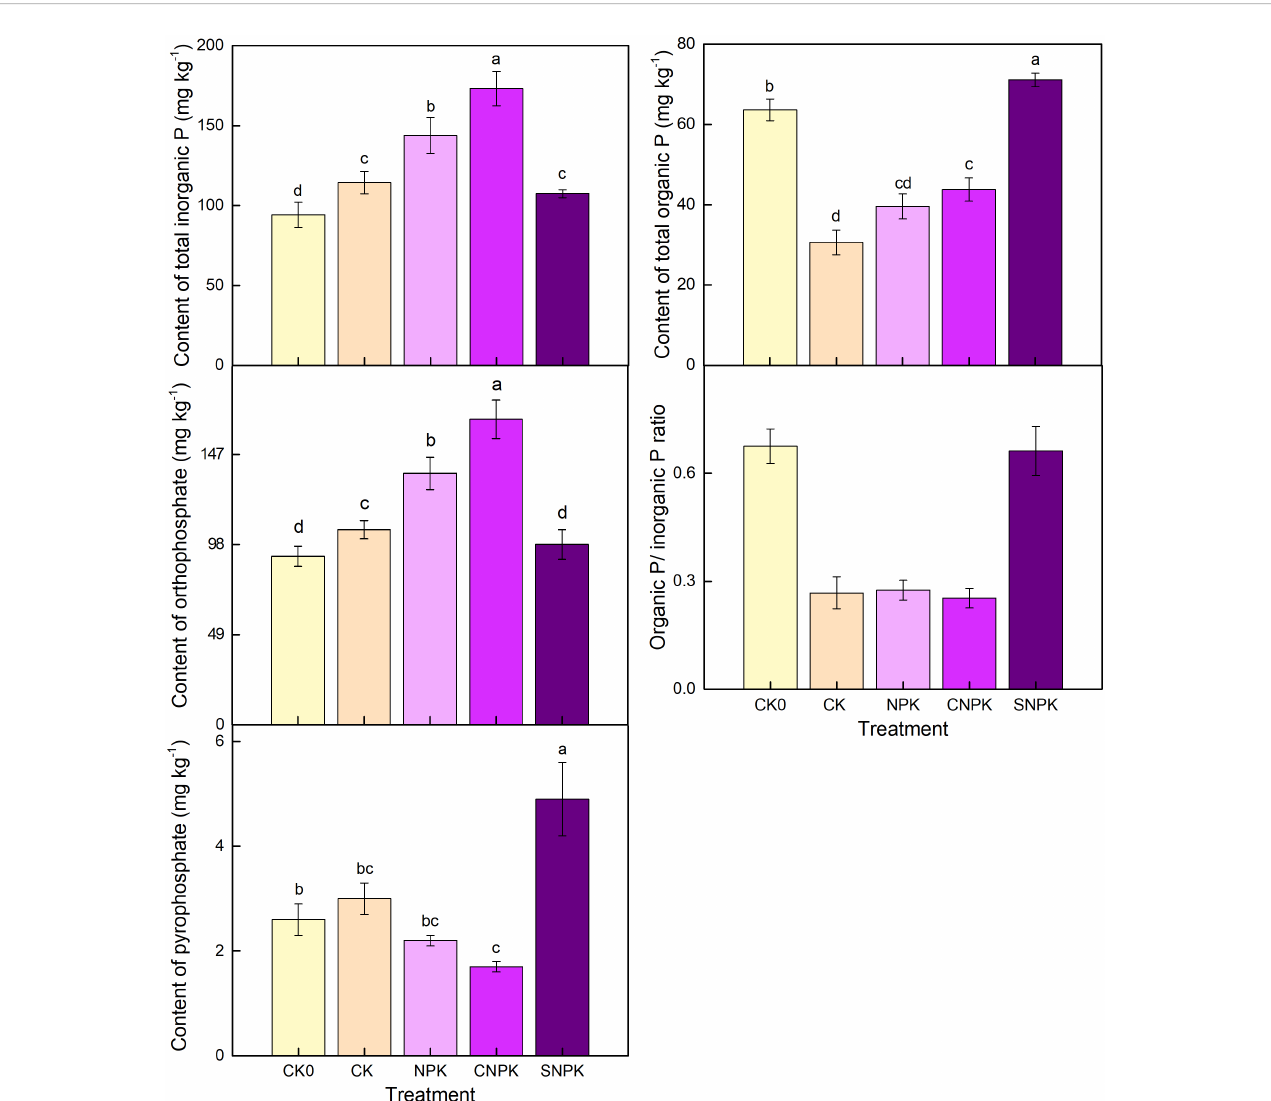
FIGURE 6 Effects of different treatments on total inorganic P, total organic P, orthophosphate, pyrophosphate, and organic P/inorganic P ratio by solution 31- phosphorus nuclear magnetic resonance spectra. Error bars represent standard deviation, n = 3. Different letters in a column indicate signi fi cant differences at the 0.05 level. CK0: initial soil; CK: non-fertilizer; NPK: NPK fertilizer; CNPK: biochar + NPK fertilizer; SNPK: corn stover + NPK